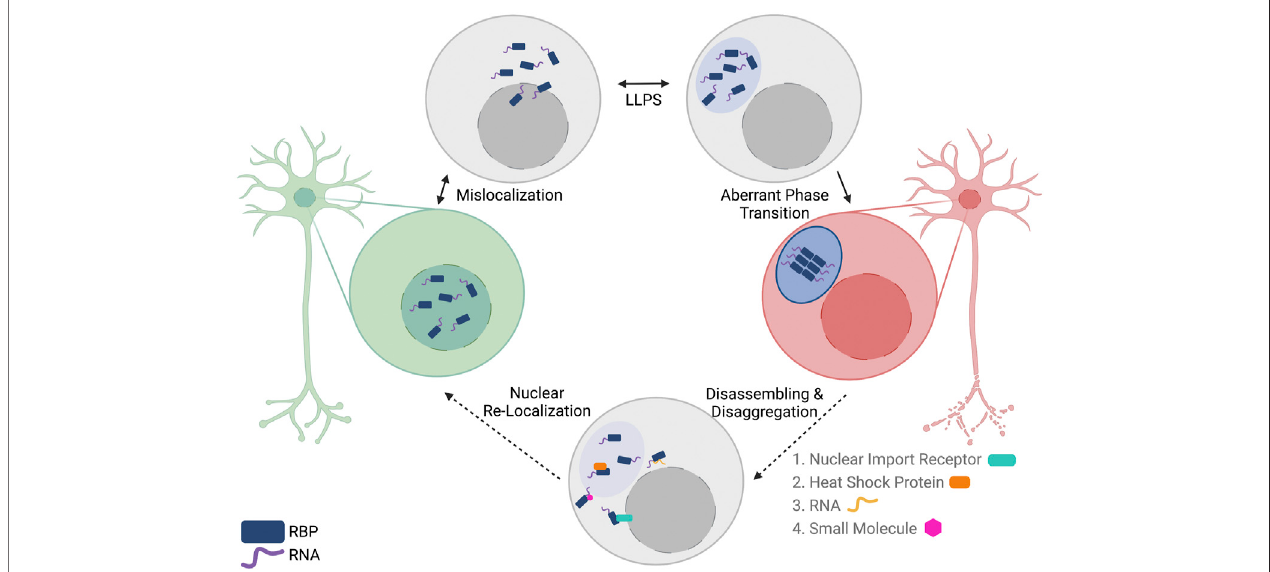
FIGURE 3 | Reversing aberrant phase transition of nuclear RNA-binding proteins (RBPs) as a potential therapeutic option for patients with ALS/FTD. In ALS/FTD, nuclear RBPsare fi rst mislocalized tothe cytoplasm. Inthe cytoplasm, RBPs canundergo reversible liquid-liquid phase separation (LLPS) toform liquid condensates. In some cases, RBPs undergo aberrant phase transition into a solid-like phase where the RBPs can assemble into fi brils. Multiple methods of disassembling and disaggregating proteins are proposed, including the use of proteins, RNAs, and small molecules. These biomolecules could potentially reverse aberrant phase transition and allow for subsequent nuclear localization of the RBPs by canonical mechanisms. Created with